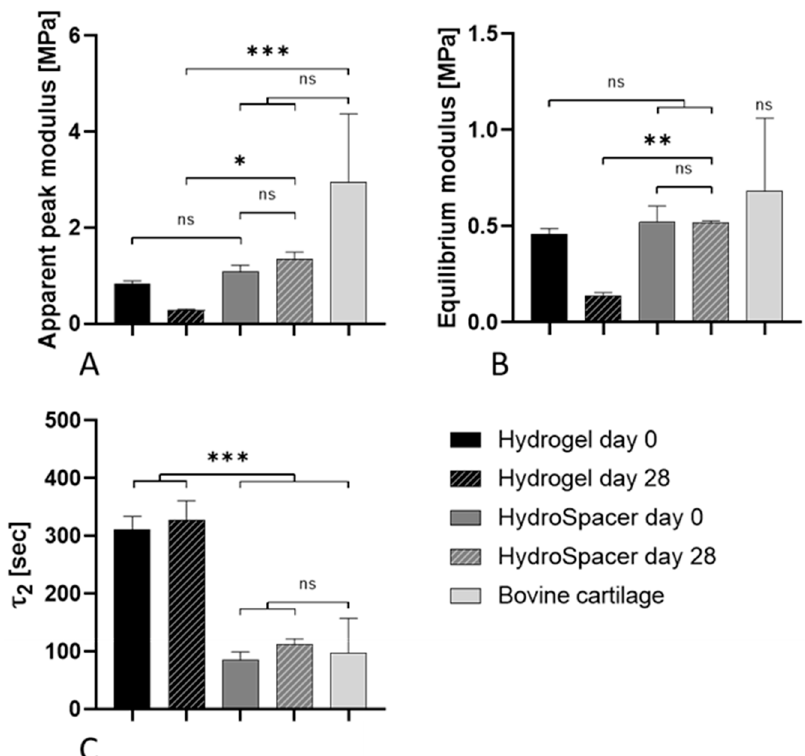
Figure 4. Mechanical properties of CSMA/HAMA hydrogels and HydroSpacers ( n = 5) at day 0 and day 28, and of bovine cartilage. ( A ) Apparent peak modulus. ( B ) Equilibrium modulus. ( C ) Time constant τ 2 in seconds. Data are presented as the mean ± SD. A Kruskal–Wallis test was performed using Prism GraphPad. The significance is indicated with *, ** or ***, with single signs referring to a p ‐ value < 0.05, double signs referring to a p ‐ value < 0.01 and triple signs referring to a p ‐ value < 0.001.